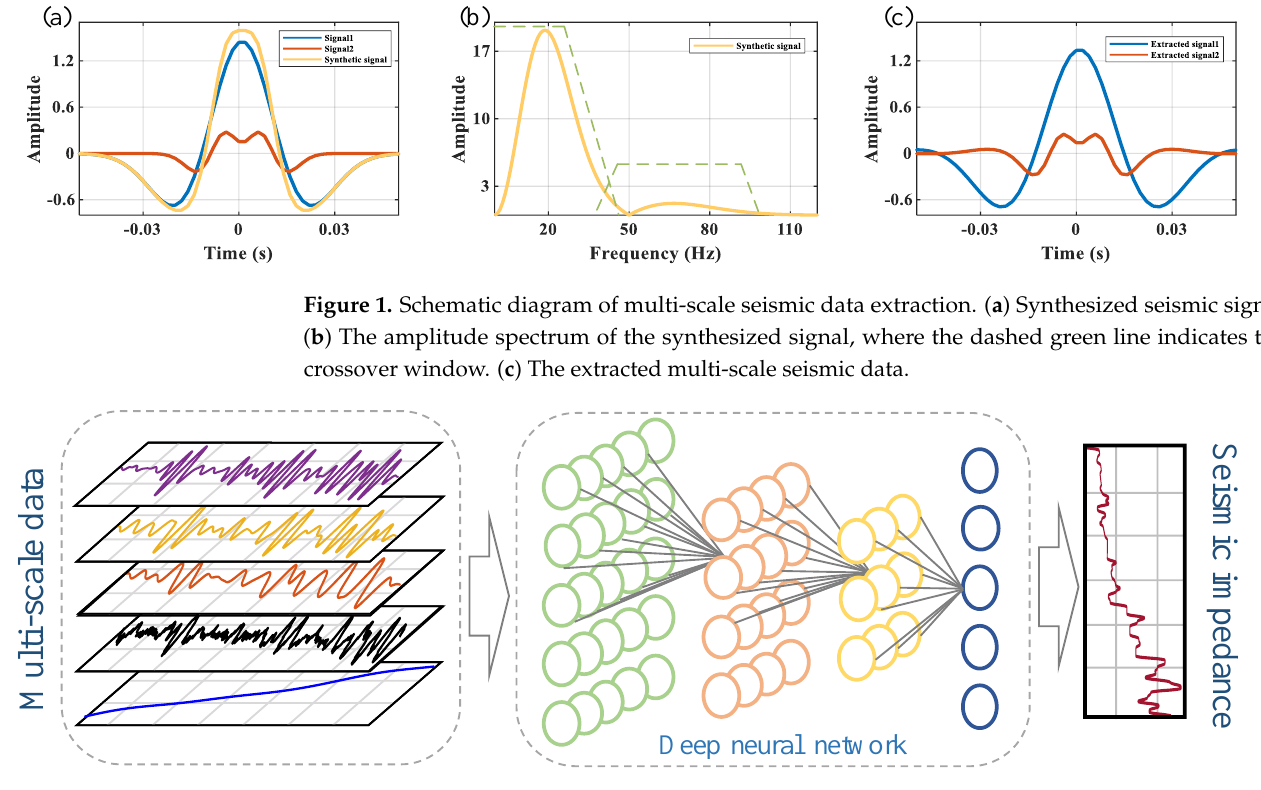
Figure 2. Deep learning seismic impedance inversion framework based on multi-scale strategy.